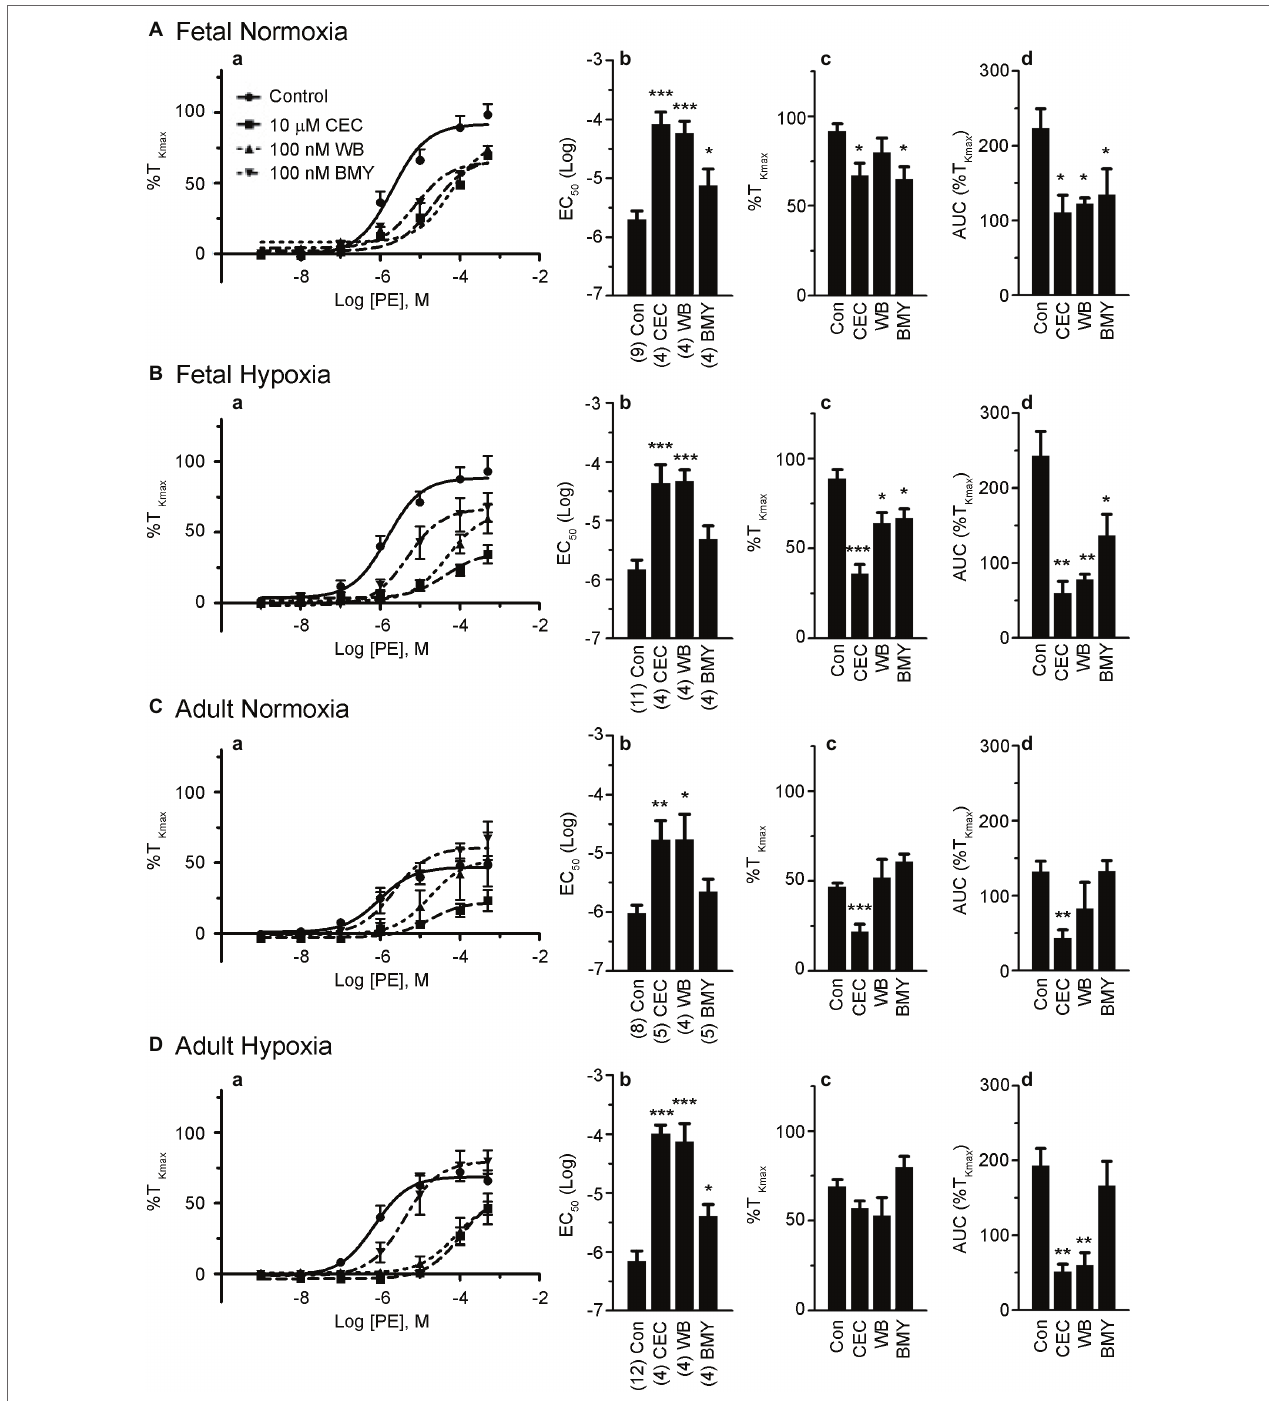
FIGURE 4 | α 1A -AR and α 1B -AR antagonists preferentially block phenylephrine-induced pulmonary vascular contractility. (a) Dose response curves of pulmonary arterial rings exposed to 1 nM to 100 μM phenylephrine in an additive manner from normoxic and LTH, fetal (A,B) and adult (C,D) sheep. Curves of log agonist vs. response were repeated in the absence (circles and solid lines) or presence of 10 μM CEC ( α 1B -AR blocker, squares and long dashed lines), 100 nM WB ( α 1A -AR blocker, triangles and short dashed lines) or 100 nM BMY ( α 1D -AR blocker, upside down triangles and dashed and dotted lines) for normoxic and LTH, fetal (A,B) and adult (C,D) sheep pulmonary arteries. (b) Log EC 50 for phenylephrine induced contraction. (c) Maximum contraction relative to high K + . (d) Area under the dose-response curve relative to high K + contraction. Points and bars are mean values while error bars indicate ± S.E.M. Comparisons of drug treated arteries to control were made using a one-way ANOVA with a Newman-Keuls Multiple Comparison Test (* p < 0.05, ** p < 0.01, *** p < 0.001). Numbers of animals for each fetal and adult group are provided in the “Methods” section and (b)